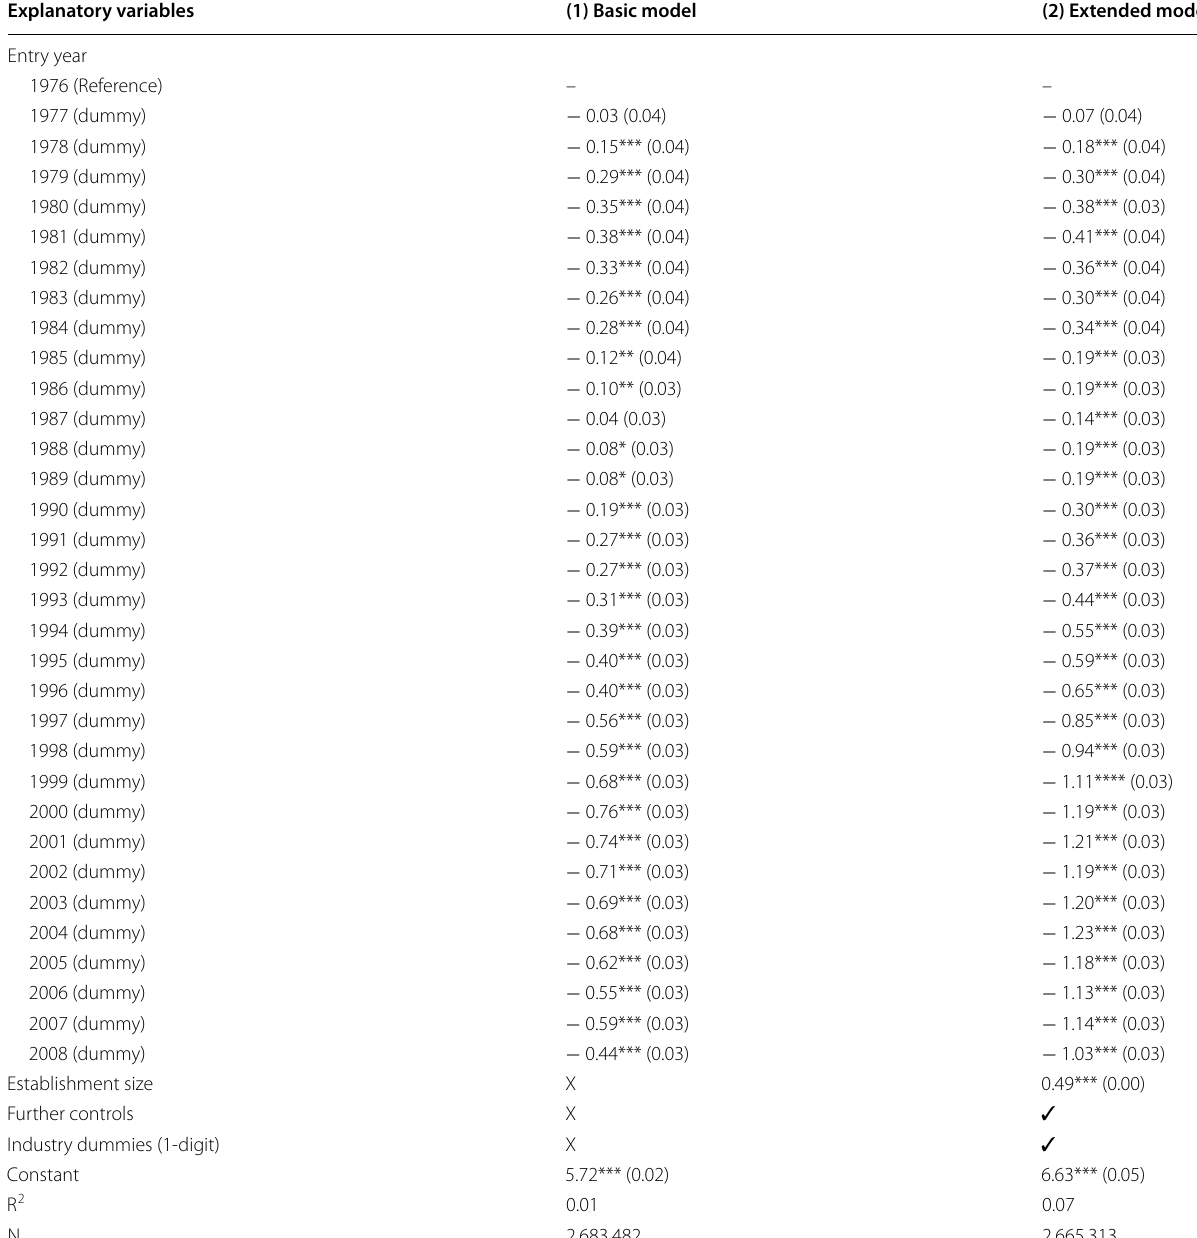
Table 6 Age at exit (1–10) as a function of the entry year, 1976–2008, OLS